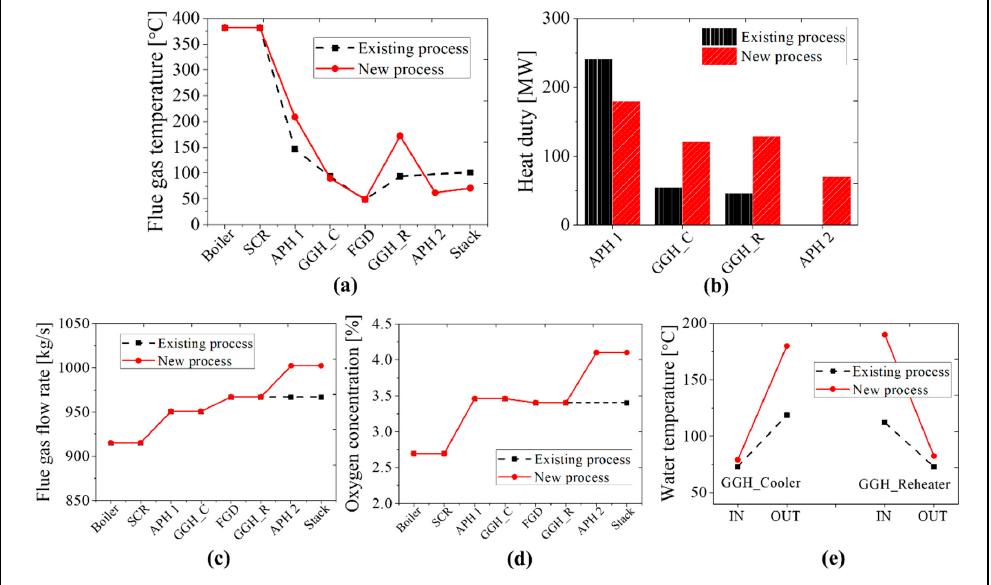
Figure 12. Comparison results between the existing and new processes at the BMCR load condition: ( a ) flue gas temperature, ( b ) heat duty, ( c ) flue gas flow rate, ( d ) oxygen concentration, and ( e ) the water temperature of the GGH. Energies 2020 , 13 , x FOR PEER REVIEW 16 of 22